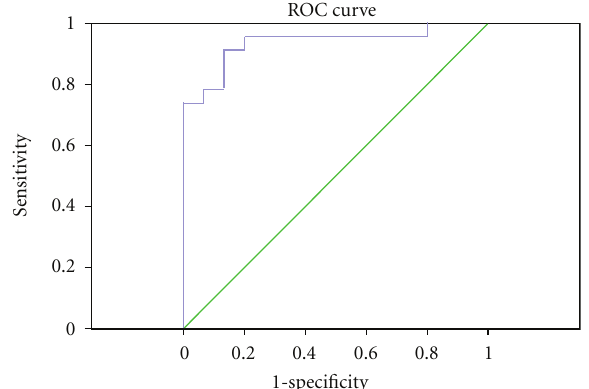
Figure 5: ROC of diagnosis model for gastric cancer (AUC = 0 . 936).